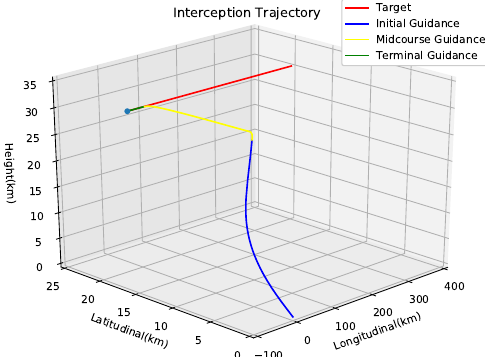
Figure 7. Interception trajectory (target non-maneuvering).